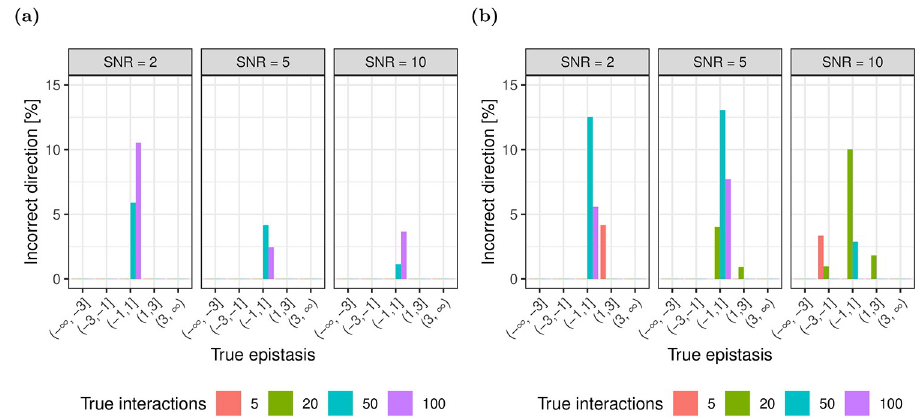
Fig 6. Concordance between the sign of true and estimated epistasis. The fraction of incorrectly identified signs between true and estimated epistasis for (a) glinternet and (b) xyz .